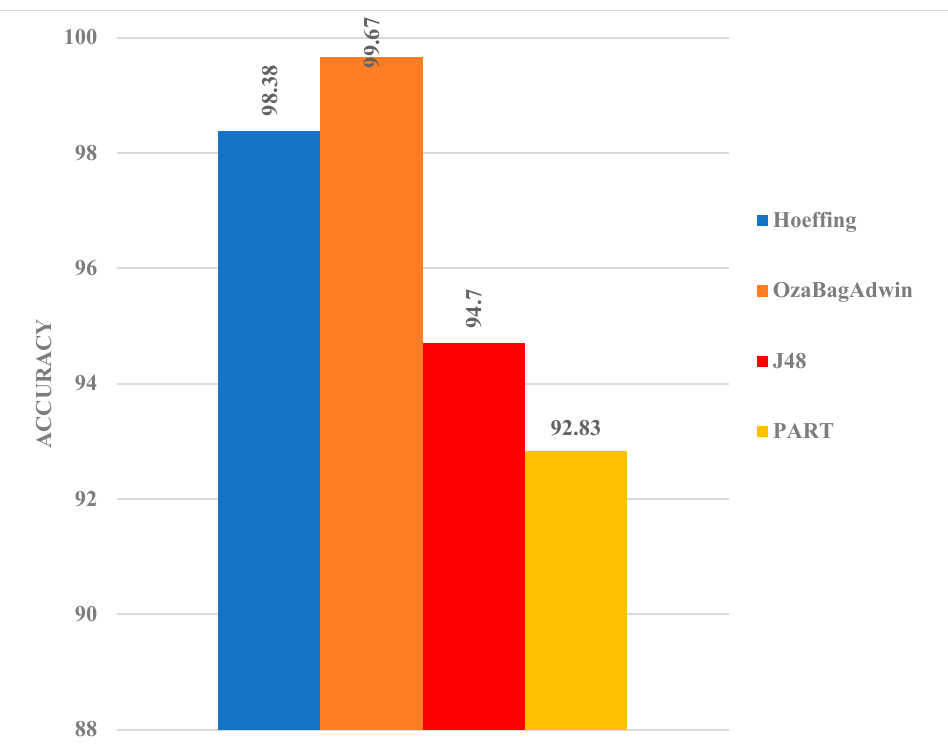
Figure 3. Model comparison based on the binary class classification.